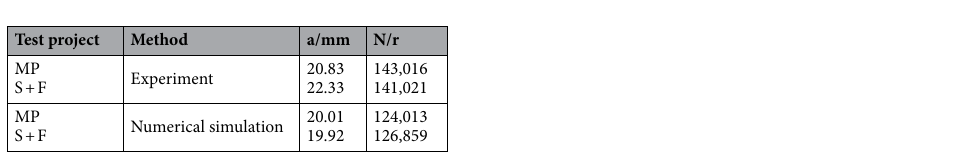
Figure 4. Experiment and numerical simulation results: ( a ) MP fitting results; ( b ) S + F fitting results; ( c ) “intersection phenomena”; ( d ) MP validation results; ( e ) S + F validation results; ( f ) MP Paris results; ( g ) S + F Paris results.